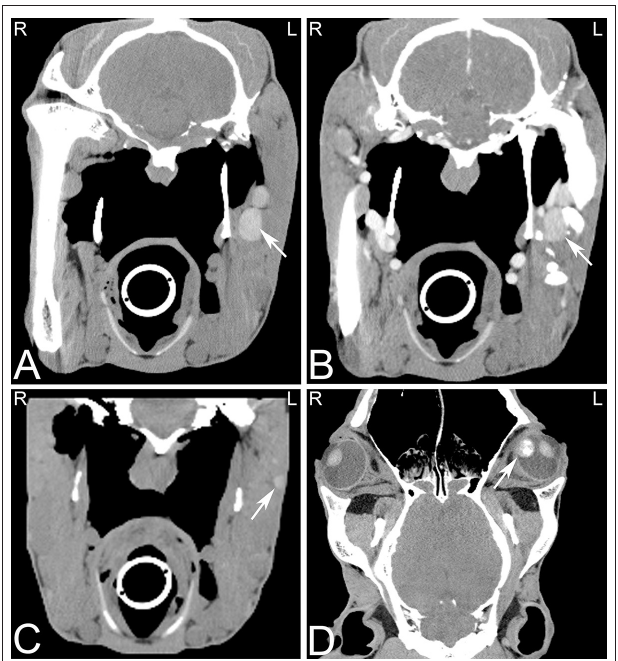
FIGURE 18 | Multiple melanomas. Transverse (A–C) and dorsal (D) computed tomography images displayed in a soft tissue window of a 17-year-old Hanoverian horse demonstrating multiple hyperattenuating nodules in the musculature, pharyngeal and guttural pouch areas, and eye secondary to melanoma. CT images at the level of the guttural pouch before (A) and after intravenous iodinated contrast agent injection (B) . A round to ovoid uniform hyperattenuating group of nodules, which are mildly uniformly contrast enhancing is noted at the lateral aspect of the left guttural pouch. Additional hyperattenuating nodules were noted in musculature of the head (C) and in the medial aspect of the vitreous body of the left eye (D) . The nodule in the left eye showed also an area of heterogeneous mineral attenuation. L, left; R, right.